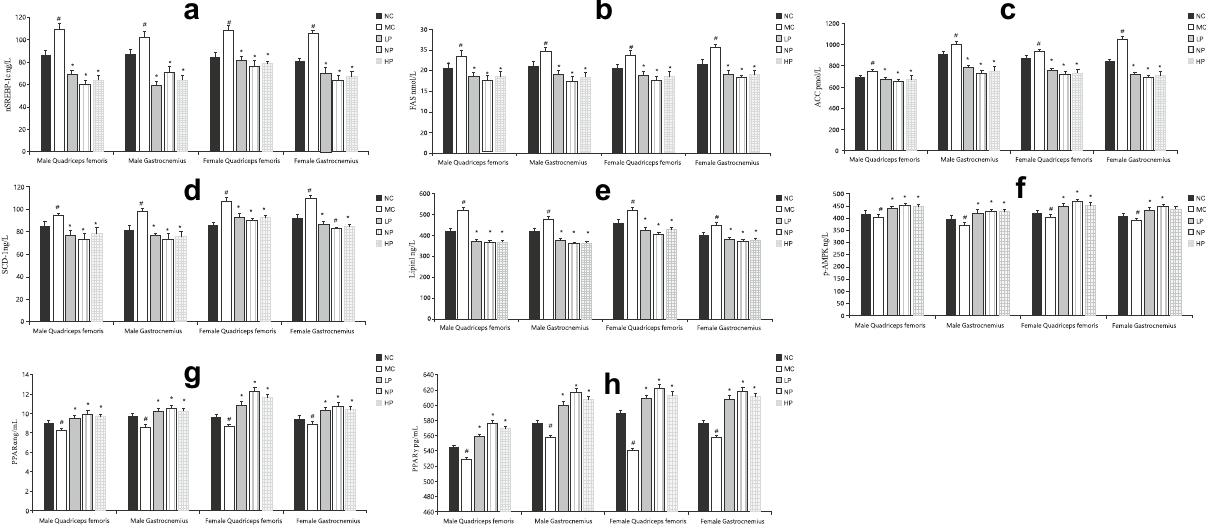
Figure 6. Concentration of factors in the pathways associated with the fat metabolism in the skeletal muscles of different groups. ( a ) Statistical analysis of nSREBP-1c. ( b ) Statistical analysis of FAS. ( c ) Statistical analysis of ACC. ( d ) Statistical analysis of SCD-1. ( e ) Statistical analysis of lipin1. ( f ) Statistical analysis of p-AMPK. ( g ) Statistical analysis of PPARα. ( h ) Statistical analysis of PPARγ. Mean values of the same muscle type and the same sex with different superscript symbols (#, *) were significantly different ( P <